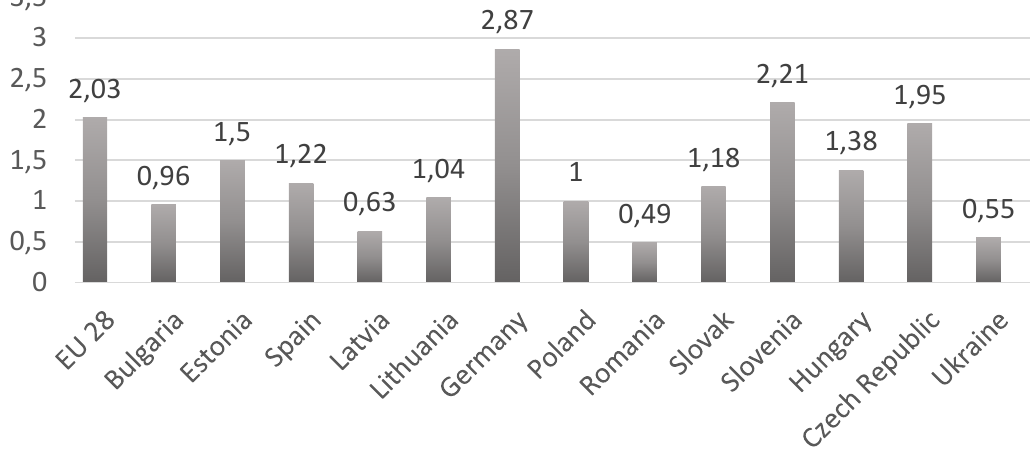
Figure 1. Specific weight of R & D expenditures as part of GDP in EU countries and Ukraine, 2016 , %